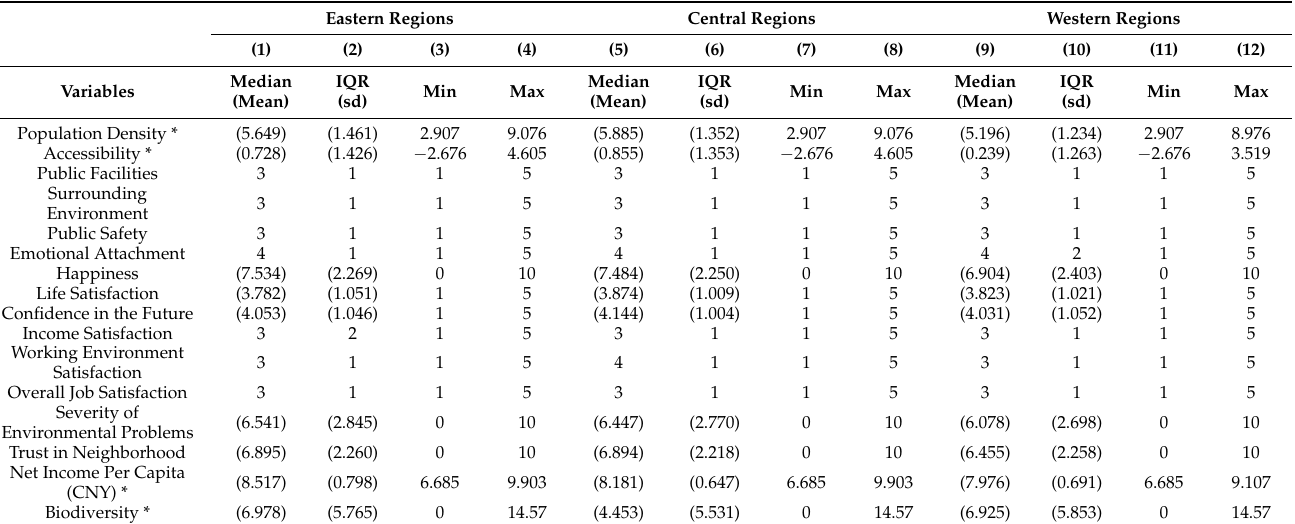
Table 4. Descriptive statistics for the covariate, individual- and community-level variables derived from samples of the eastern (n = 2719), central (n = 2130) and western regions (n = 2679). Eastern Regions Central Regions Western Regions